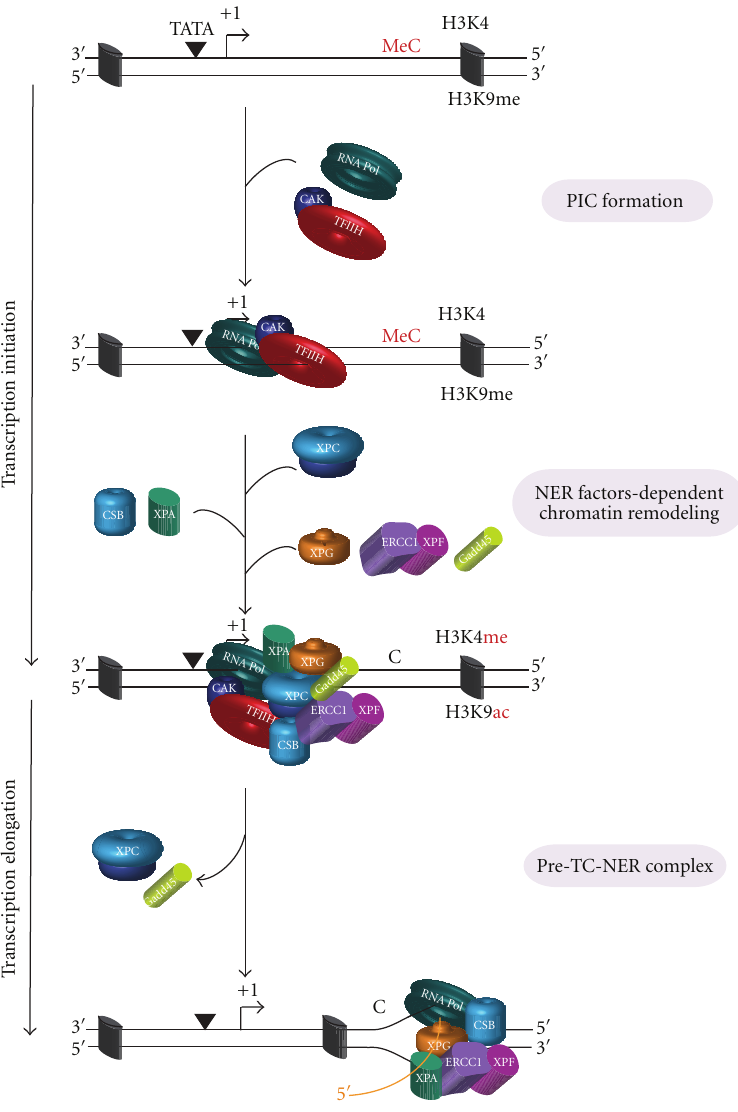
Figure 3: NER factors and gene transcription. Upon gene activation, the formation of preinitiation complex (PIC) precedes the recruitment of XPC, which allows the sequential arrival of the other NER factors in the following order CSB, XPA/RPA, XPG/ERCC1-XPF, and Gadd45 α . The association of NER factors and Gadd45 α with the transcription machinery leads to a cascade of histone PTMs. Concomitantly, an active demethylation of 5 (cid:2) CpG islands